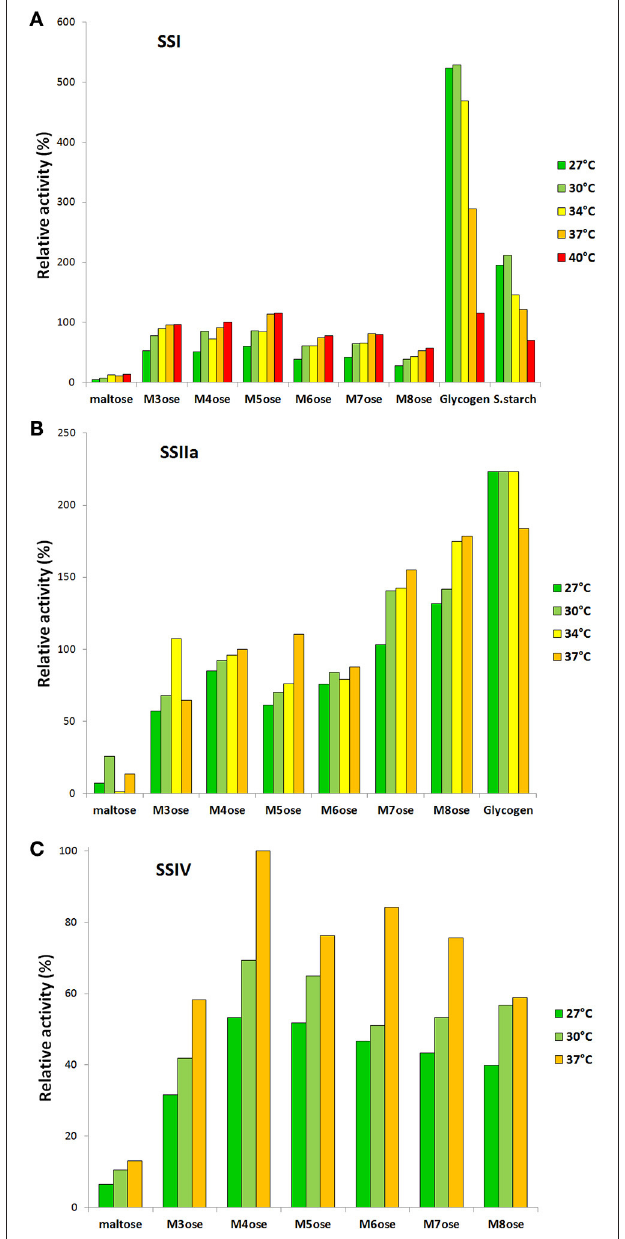
FIGURE 5 | Variation of SS activity with temperature. (A) Compared activity of SSI with different acceptors at different temperatures. The first seven are linear MOS, the last two branched polysaccharides, assayed at 0.1mg/mL. All data presented as relative values to maltotetroase at 37 ◦ C. (B) The same for SSIIa, glycogen at 1mg/mL concentration. (C) The same for SSIV. The assay temperatures are different from panel to panel, as are the gaps between temperatures, but the color scheme has been kept